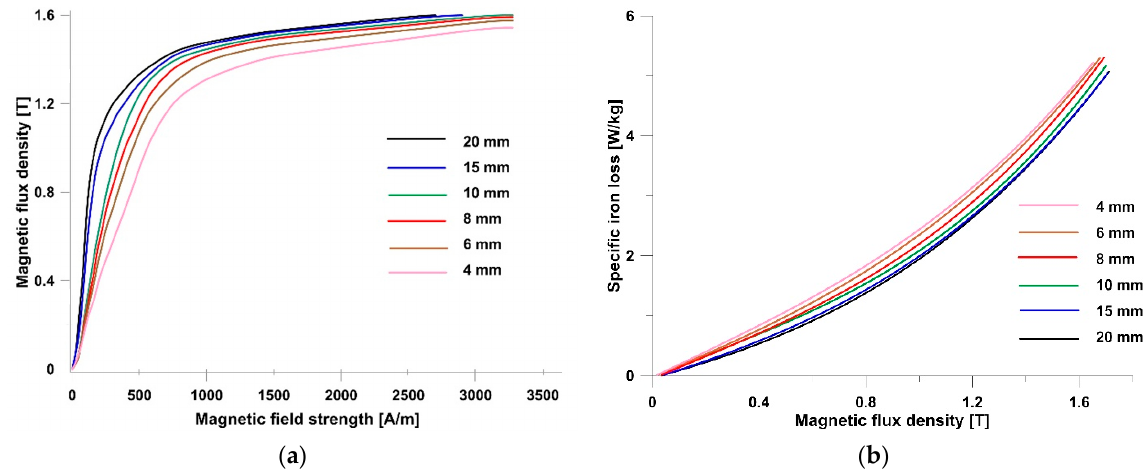
Figure 4. The measured (green) and calculated B-H curves ( a ) and specific iron loss curves ( b ), for 50 Hz, and varying strip width.